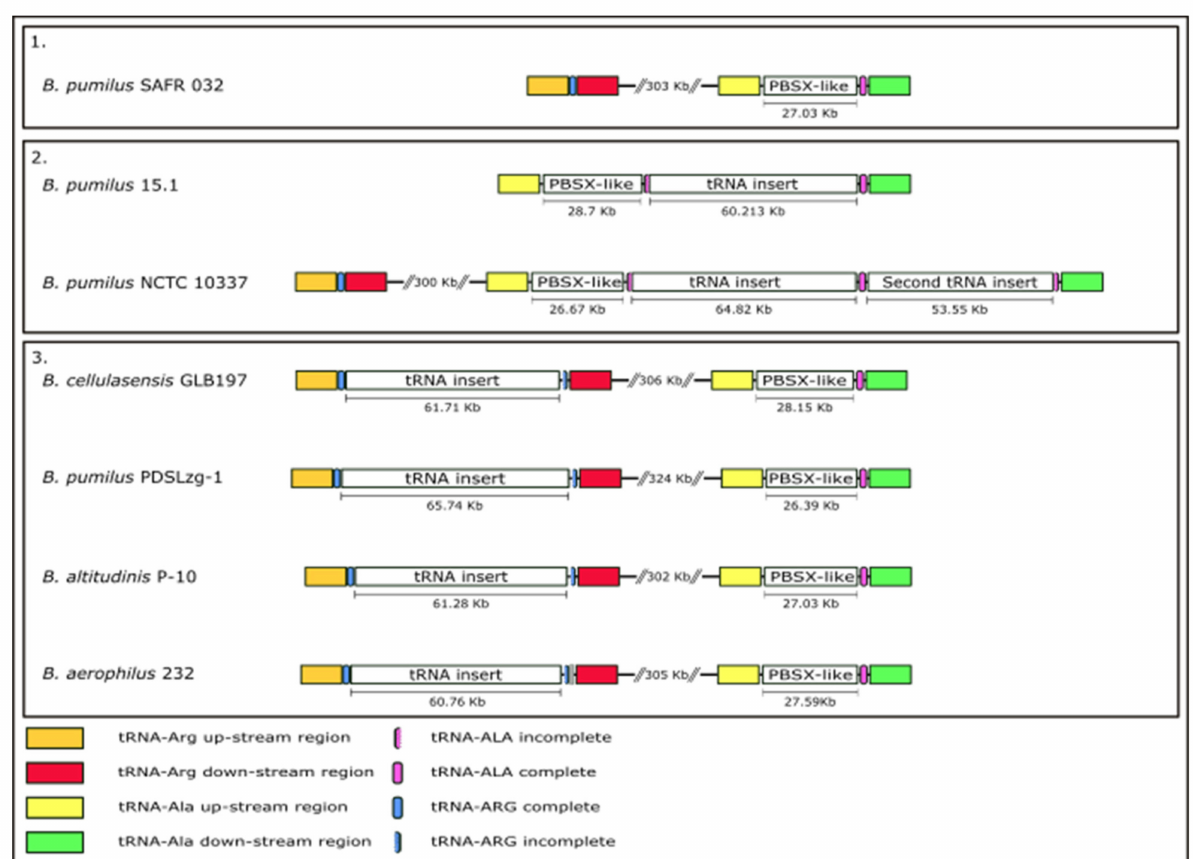
Figure 6. Genomic organisation comparison of the 60.2 Kb insertion in B. pumilus related strains. The relative position of the tRNA inserts and PBSX-like particles are shown in the six strains and compared to the model strain B. pumilus SAFR 032 (panel 1), which lacks tRNA inserts. tRNA-Arg gene is shown in blue, and tRNA-Ala is shown in pink. In most Bacillus species (panel 1), the PBSX-like region is adjacent to the tRNA-Ala. In B. pumilus 15.1 and NCTC 10337 (panel 2), tRNA insert is adjacent to PBSX-like region, in the tRNA-Ala gene. However, in B. cellulasensis GLB197, B. pumilus PDSLzg-1, B. altitudinis P-10 and B. aerophilus 232, inserts are present in the tRNA-Arg gene, circa 300 bp upstream PBSX-like genome (panel